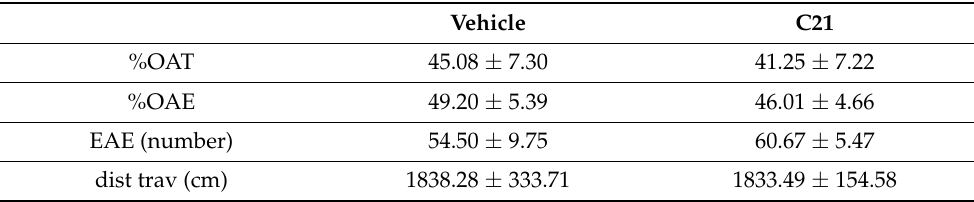
Table 1. Effect of C21 (0.3 mg/kg, intranasal) in the elevated